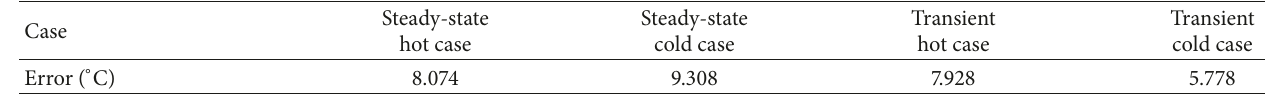
Table 2: Temperature errors of the base models ( ∘ C).